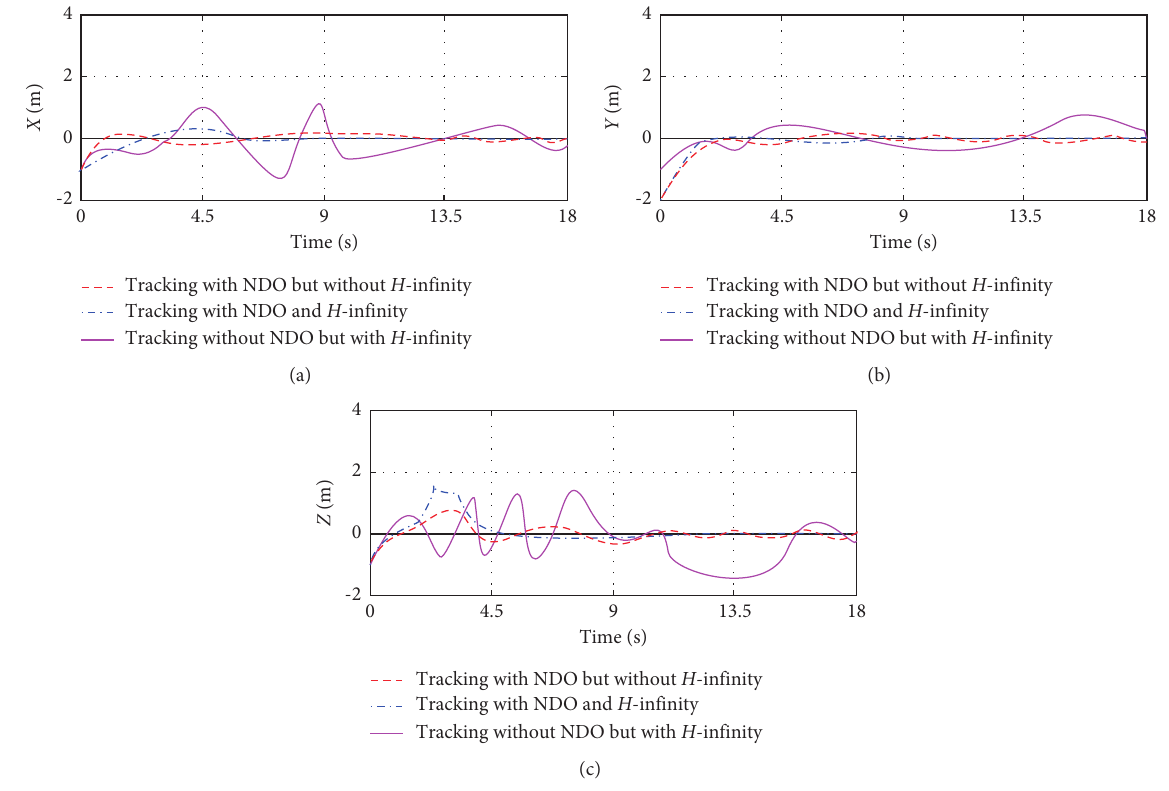
controller. (a) Time ∞